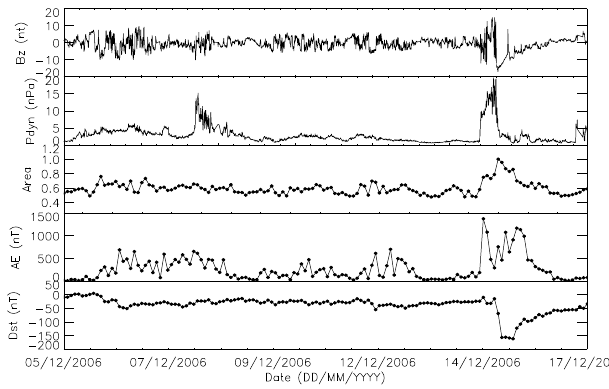
Figure 8. Same as Fig. 7 except during 5–17 December 2006.